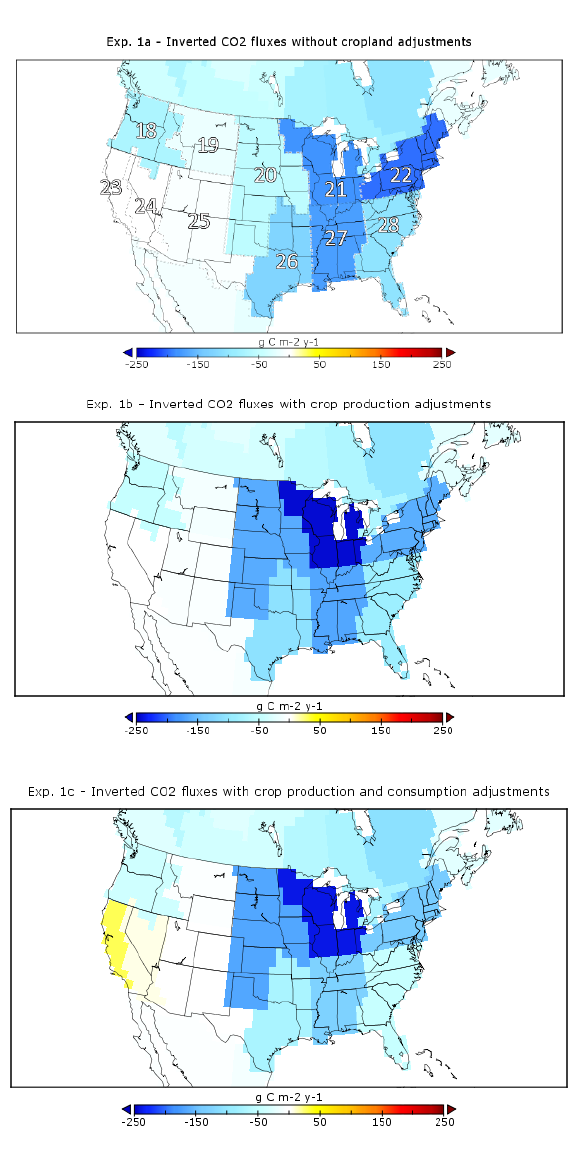
Figure 3. Map of mean annual inverted CO 2 flux for experiment 1 during 2002 to 2007 over contiguous US regions. Negative values represent carbon